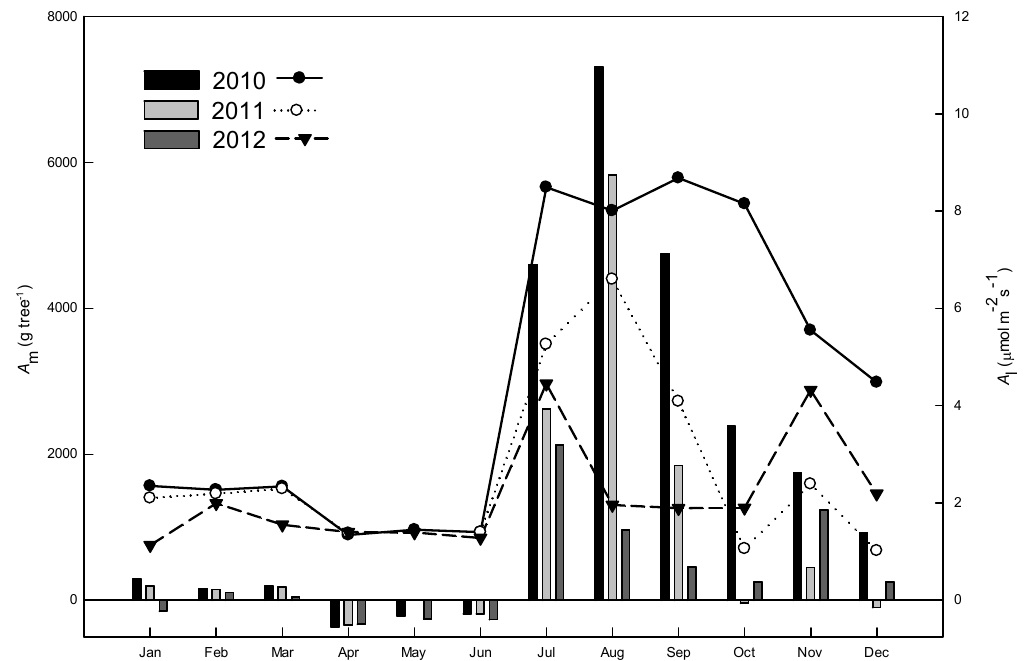
Figure 4. The leaf-level CO 2 assimilation rate ( A l , lines) and tree-level monthly CO 2 assimilation ( A m , Figure 4. The leaf ‐ level CO 2 assimilation rate ( A l , lines) and tree ‐ level monthly CO 2 assimilation ( A m , bars) of Fraxinus griffithii from 2010 to 2012. bars) of Fraxinus griffithii from 2010 to 2012.